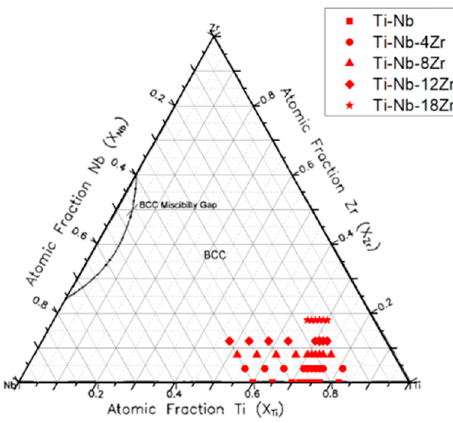
Figure 1. Alloy compositions investigated in this study in the isothermal sections of the Ti–Nb–Zr phase diagram at 1173 K [59].